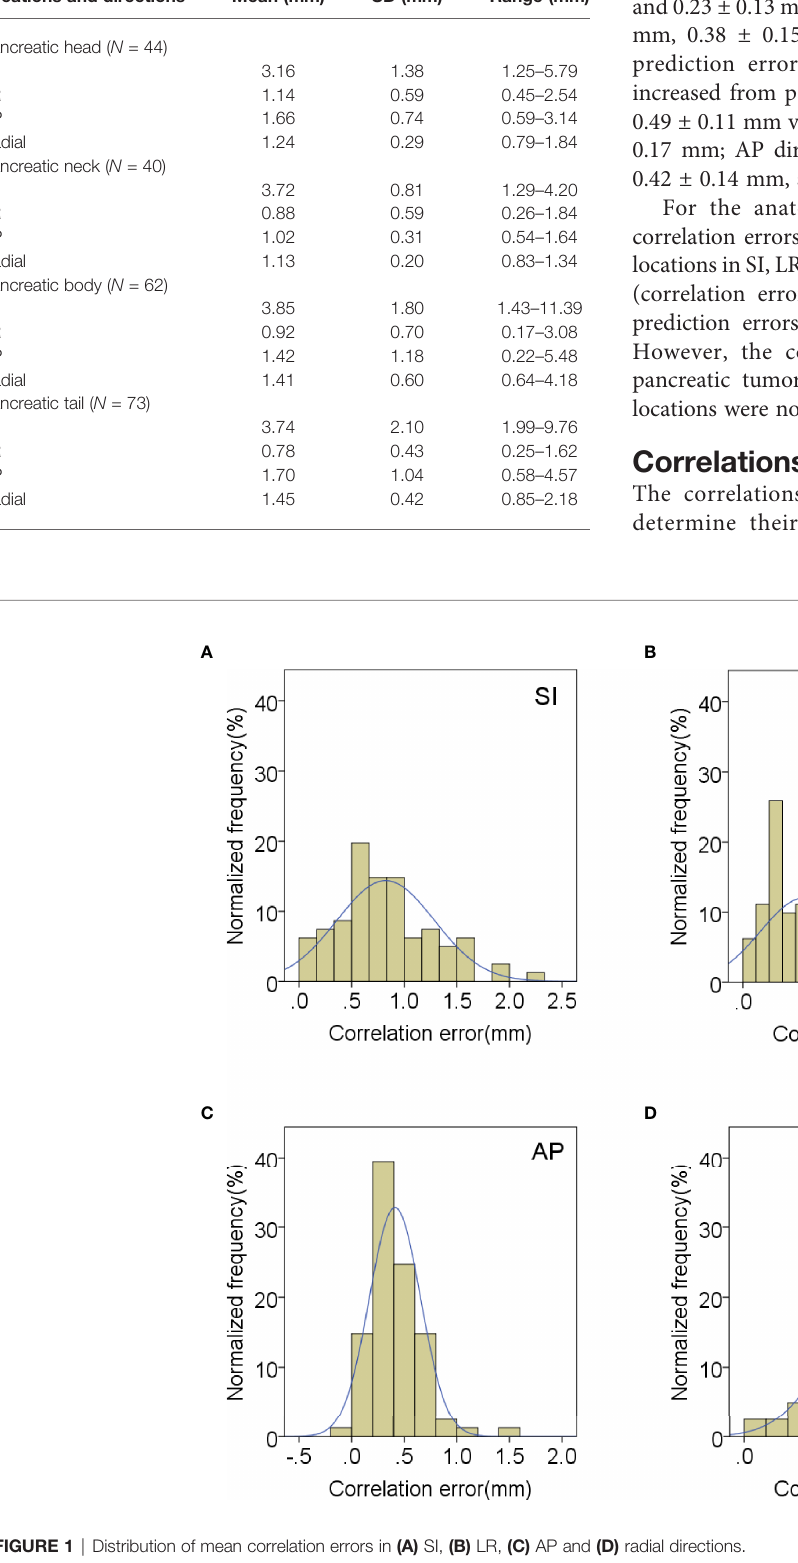
TABLE 1 | Overview of pancreatic tumor motion at different anatomical locations. Locations and